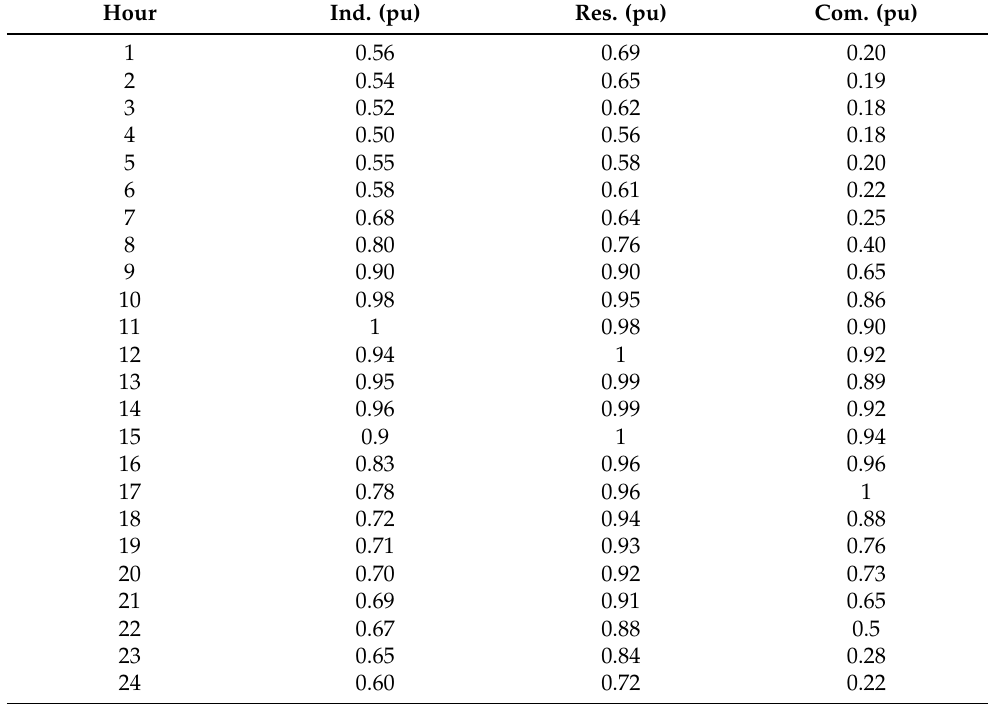
Table 3. Daily demand profiles for all the areas depicted in Figure